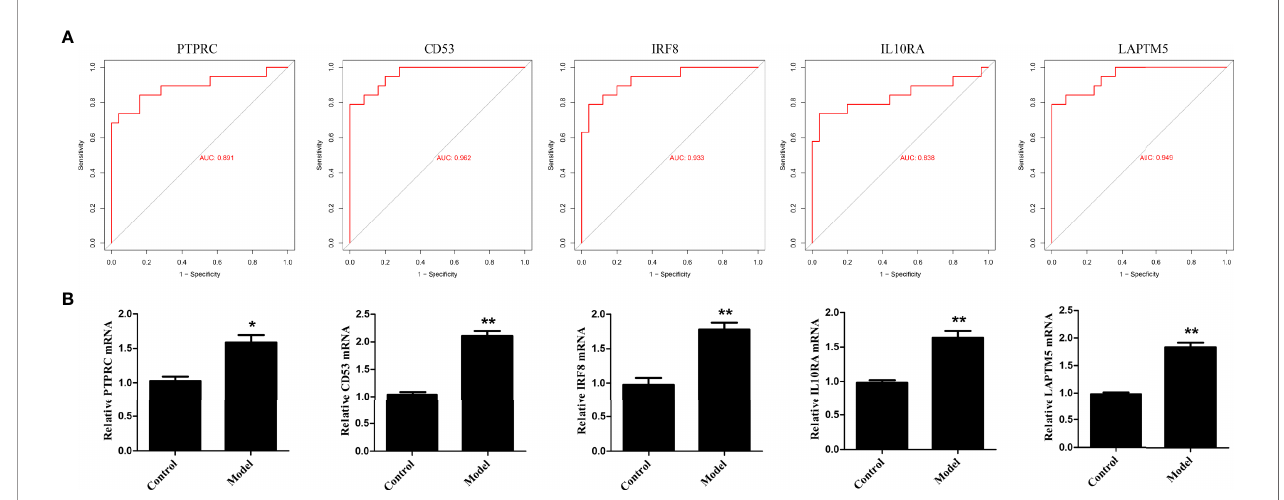
FIGURE 10 | Validation of hub genes. (A) ROC curve of the hub genes in GEO datasets. (B) The relative expression of hub genes was detected by RT-PCR. *p < 0.05, **p <